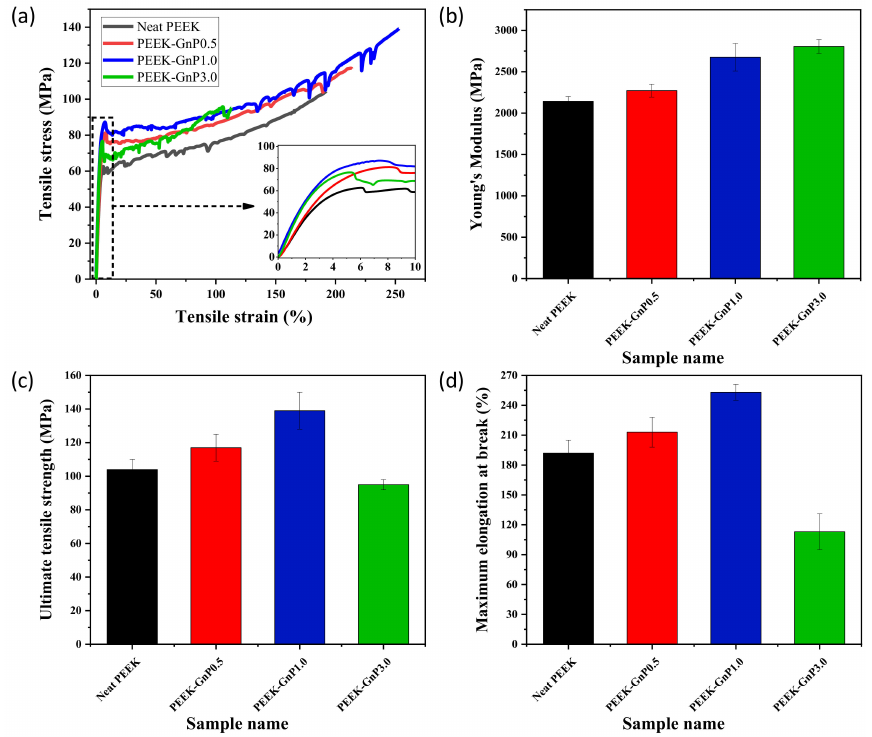
Figure 7. Tensile properties of the neat PEEK and PEEK–GnP nanocomposites filled at 0.5, 1.0, and 3.0 wt.% GnP content, ( a ) engineering stress–strain curves, ( b ) Young’s modulus, ( c ) ultimate tensile strength, and ( d ) maximum elongation at